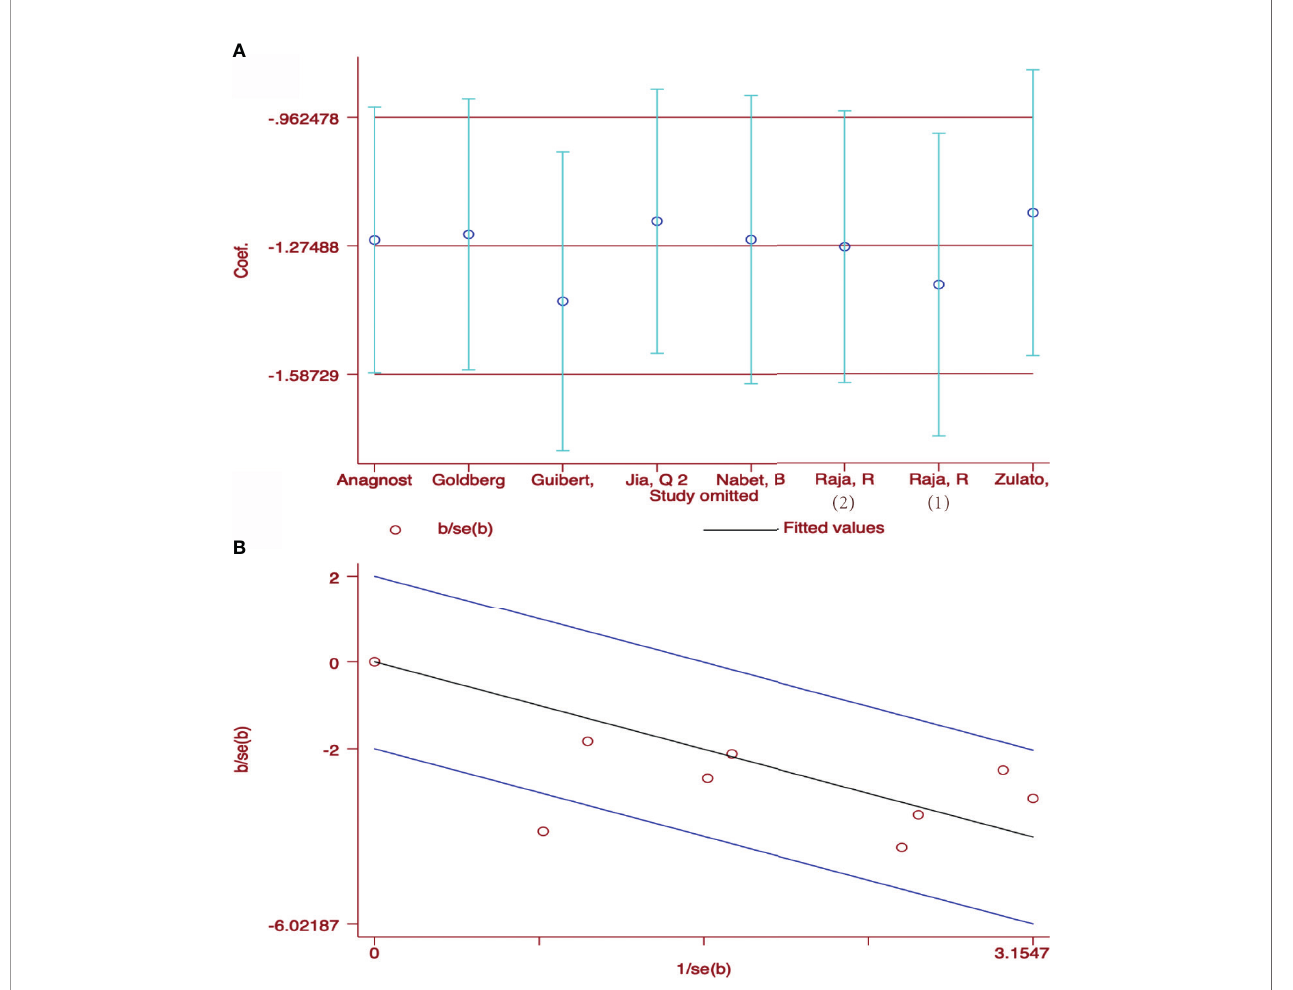
FIGURE 4 | Sensitivity analysis (A) and Star Plot (B) of the included literatures on the reduction of ctDNA with PFS as the